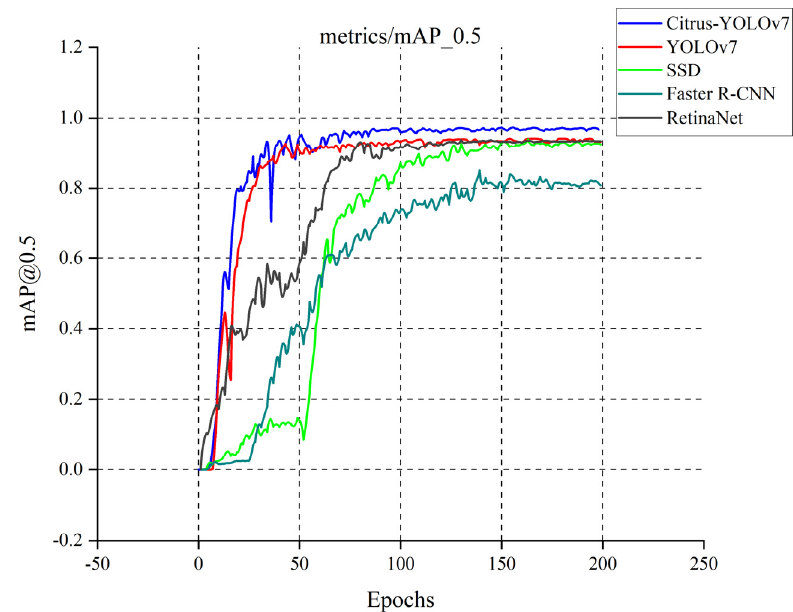
Figure 8. Accuracy variation of five object detectors.